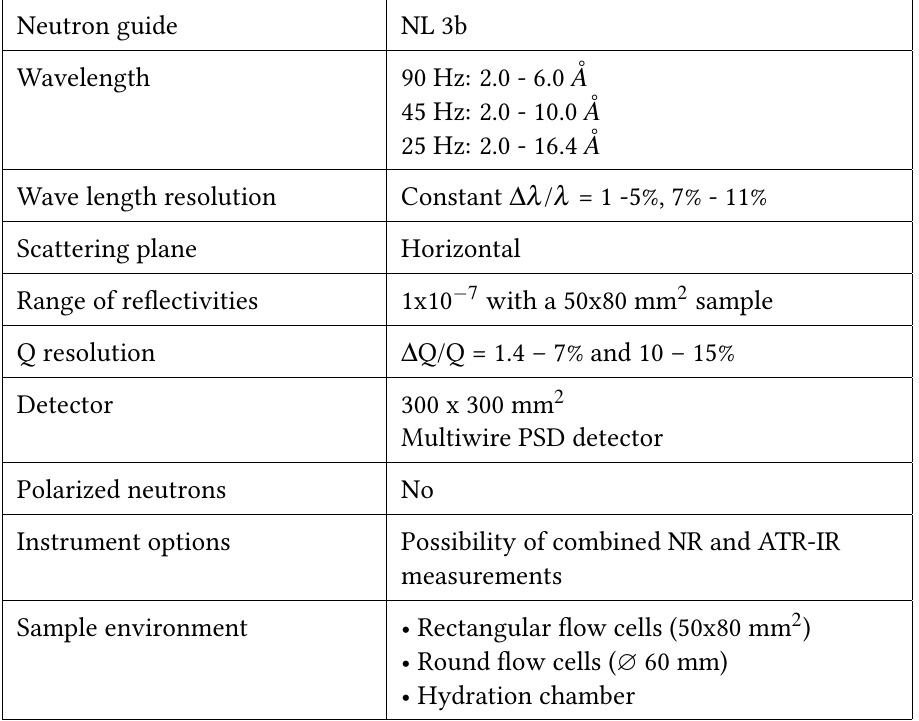
Table 1: Technical data of